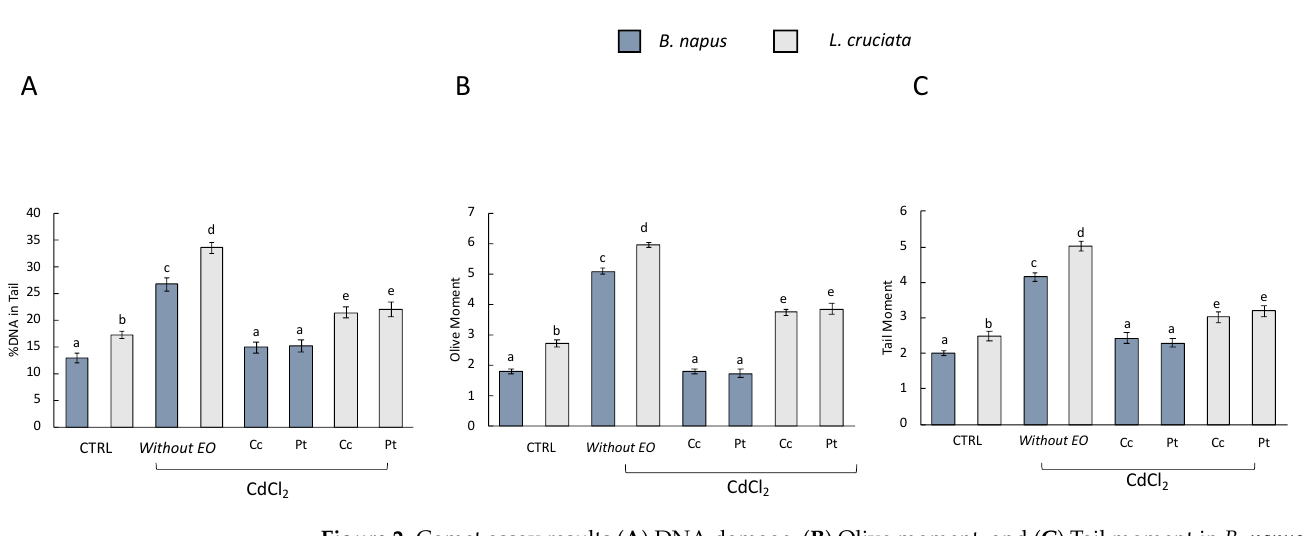
Figure 2. Comet assay results ( A ) DNA damage, ( B ) Olive moment, and ( C ) Tail moment in B. napus and L. cruciata in the control samples [i.e., without pretreatment with EOs of (Pt) and (Cc) and without treatment with CdCl 2 ], in samples without pretreatment with EOs and exposed to treatment with CdCl 2 , and in samples pretreated with EOs and exposed to CdCl 2 treatment. Bars not accompanied by the same letter (a – e) were significantly different at p < 0.05. Data are mean of three independent experiments ± SE ( n = 5).